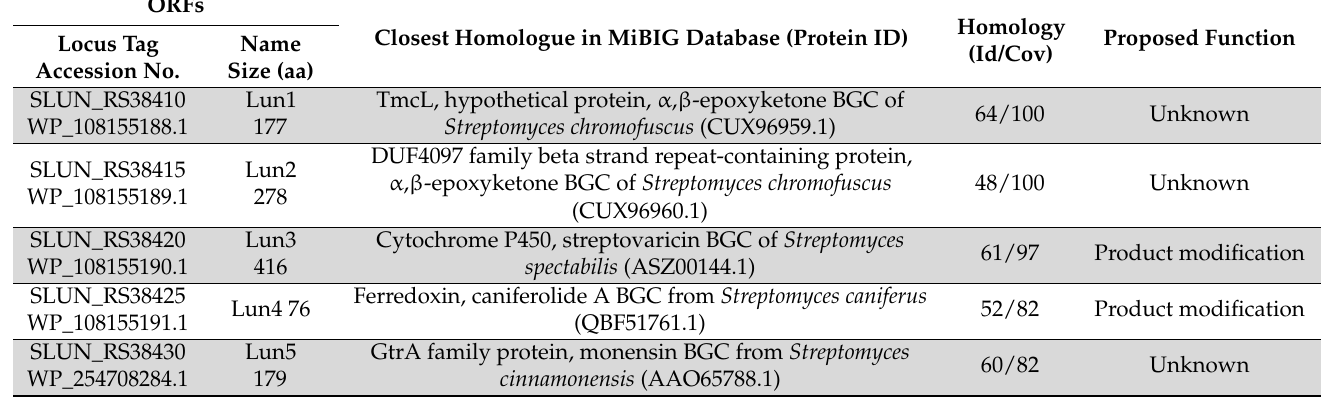
Table 1. Deduced functions of ORFs of the lun (BGC 28a) biosynthetic gene cluster of S . lunaelactis MM109 T